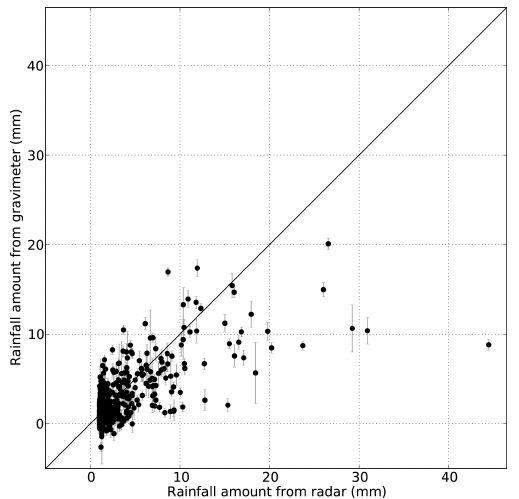
Figure 6. Rainfall amounts derived from radar and gravimeter mea- surements for 506 precipitation events with max reflectivity exceed- ing 40dBZ. The error bars show the errors caused by instrumental errors and correction of pressure effects.